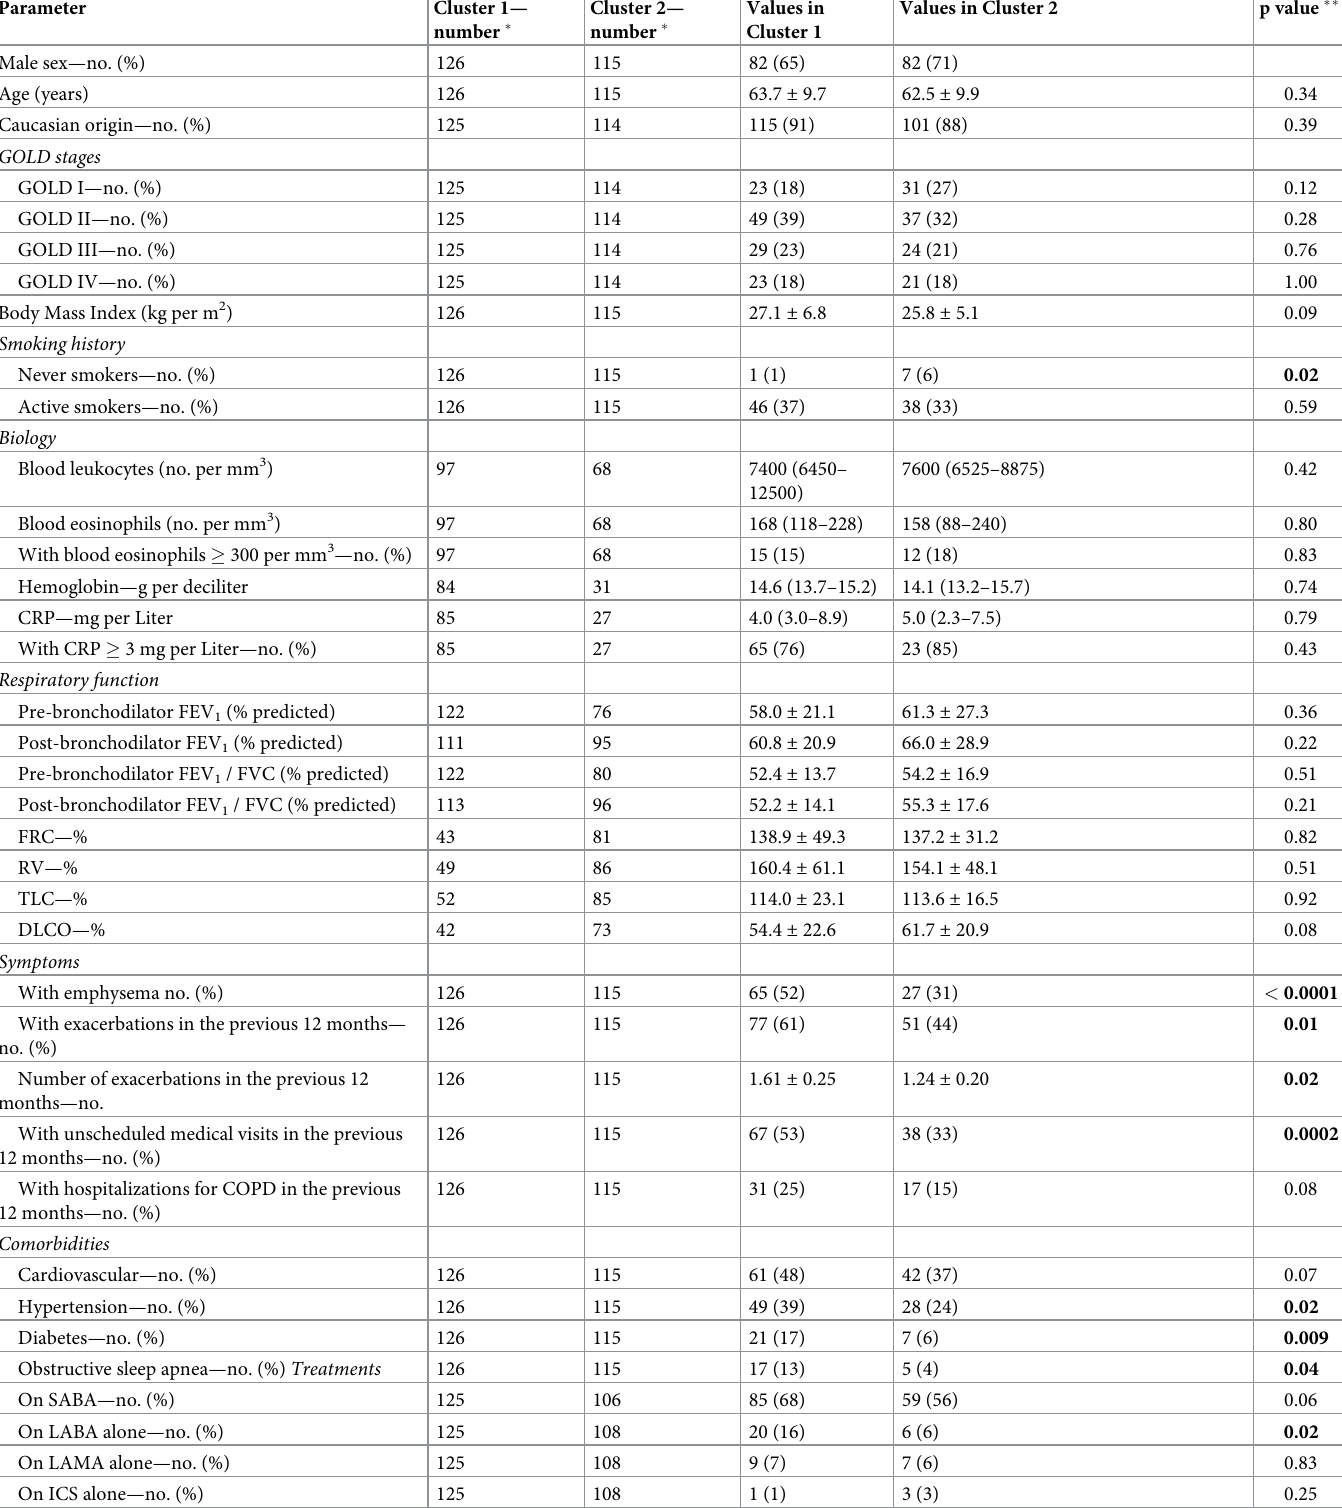
Table 2. Differences in clinical characteristics between COPD patients of Cluster 1 and Cluster 2 at visit